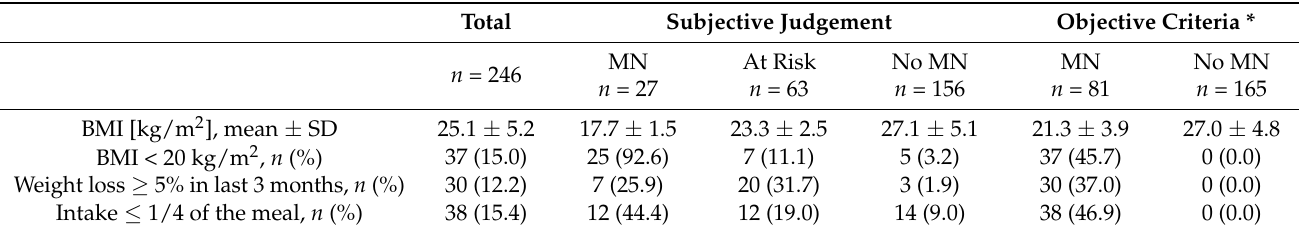
Table A1. Objective criteria for malnutrition * in the total sample, stratified by subjective judgement of malnutrition by nursing staff and by objective rating * of malnutrition (MN).